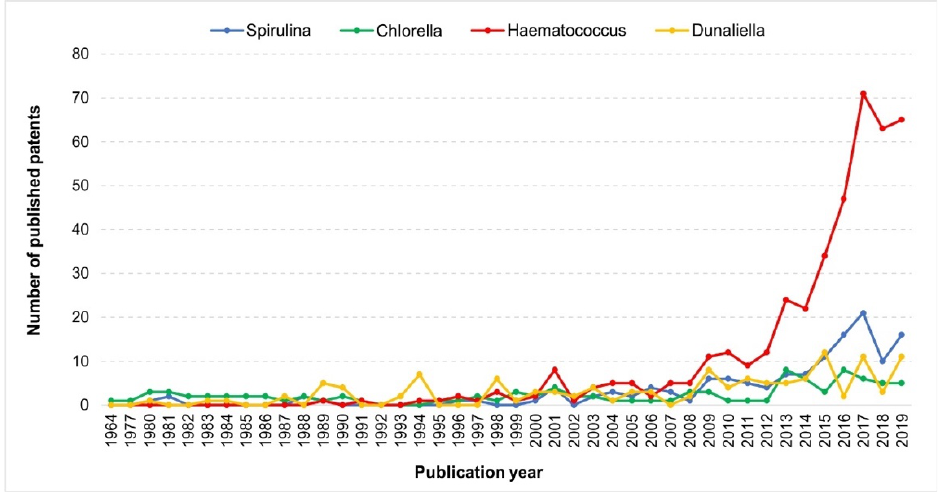
Figure 5. Evolution of the number of published patents over the years for each analysed microalga. Total number of published patents: Haematococcus : 418; Spirulina : 137; Dunaliella : 124, and Chlorella : 97. Source: Espacenet Patent database. Consulted on April 21, 2020.